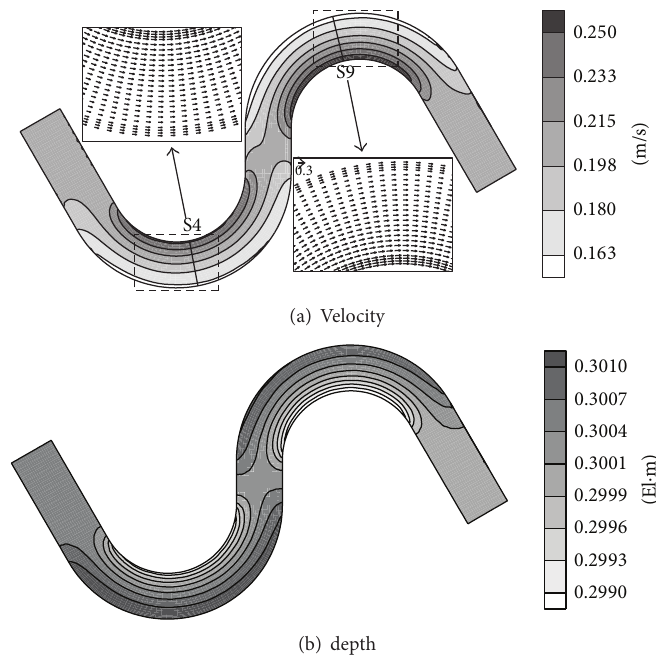
Figure 4: Velocity field and depth contour for M1 in meandering channel flow.